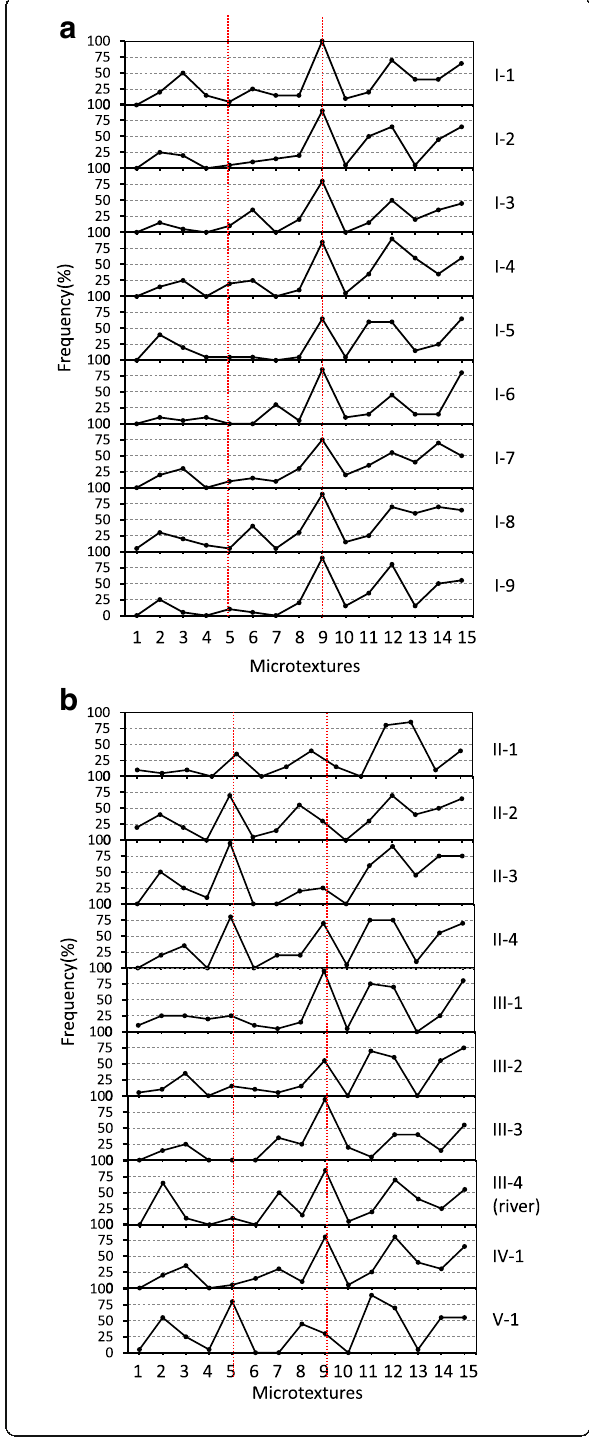
Fig. 4 Frequency of each microtexture on the quartz grain surfaces of each sample ( n = 20): a area I and b areas II – V. The microtextures are defined as follows. 1 Crystal overgrowth; 2 silica precipitation; 3 oriented etch pits; 4 solution pits; 5 small holes; 6 large holes; 7 upturned plates; 8 flat cleavage face; 9 V-shaped percussion cracks; 10 crescentic percussion marks; 11 small conchoidal fracture (<10 μ m); 12 medium conchoidal fracture (10 – 100 μ m); 13 large conchoidal fracture (>100 μ m); 14 arcuate